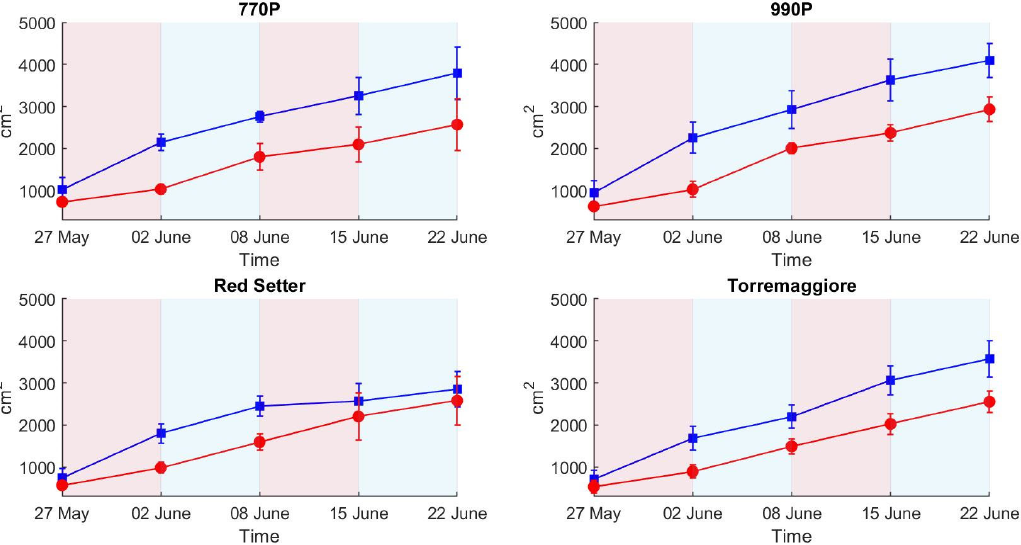
Figure 6. Projected shoot areas in stressed and control treatments (red and blue lines and points, respectively) for the four genotypes. Each point reports the mean of six samples and the associated standard deviation.